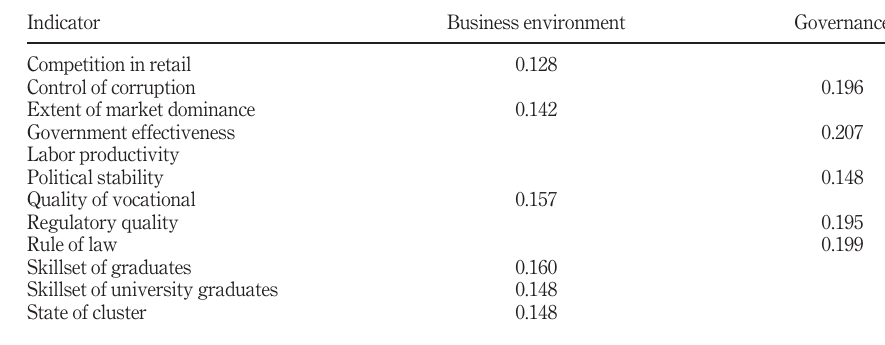
Table 7. Outer weights